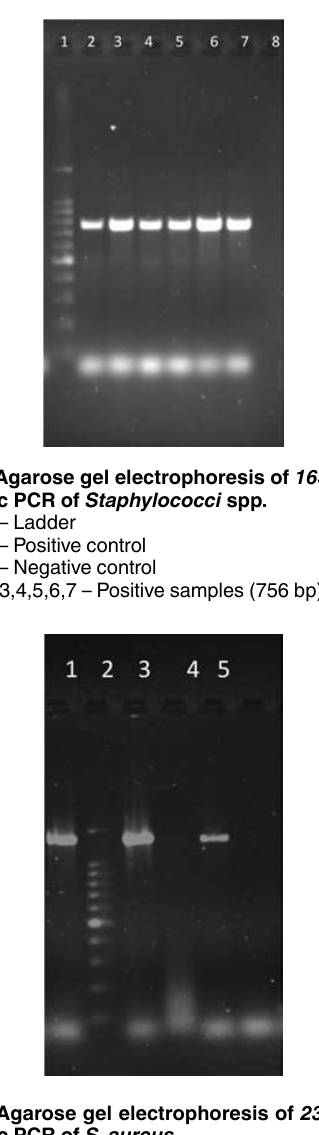
Fig. 2. Agarose gel electrophoresis of 23S rRNA specific PCR of S. aureus Lane 1,3 – Positive samples (1318 bp) Lane 2 – Ladder Lane 4 – Negative control Lane 5 – Positive control